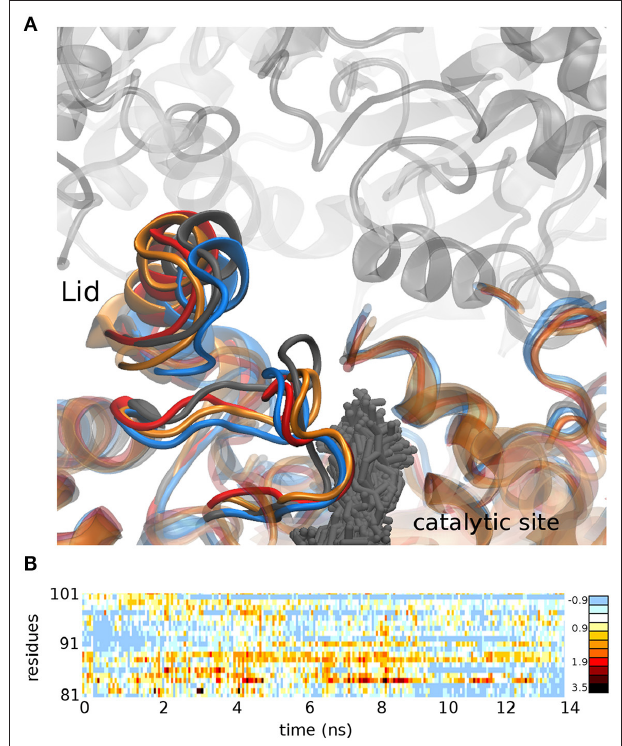
FIGURE 1 | (A) Conformation adopted after 15 ns molecular dynamics simulation in the WT OPE (gray), mutant N81A (blue), mutant N94A (red), and the double mutant N81/94A (orange). The positions adopted by the substrate pNPB in all the dynamics of the WT protein are shown (gray sticks). (B) Difference between the RMSD of mutant N81A and N94A in the lid region (residues 81-101) in a 15 ns molecular dynamics simulation. Positive values represent greater movement in the mutant N81A, while negative values represent greater movements in the mutant